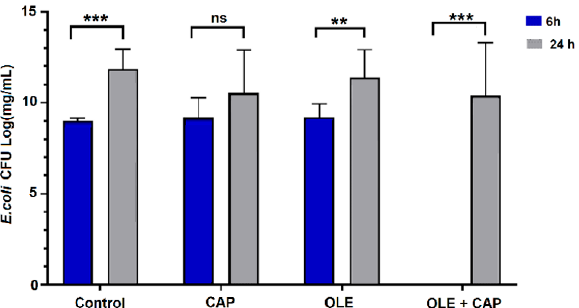
Figure 2. The effects of Cold Atmospheric Plasma (CAP) (1 min exposure time) and/or OLE on E. coli . The values are reported as mean ± standard error of the mean (SEM) (n = 3), significance at p < 0.05 by One-way ANOVA and Tukey ′ s HSD post hoc test; ** p < 0.001, *** p < 0.0001, n.s. not significant.